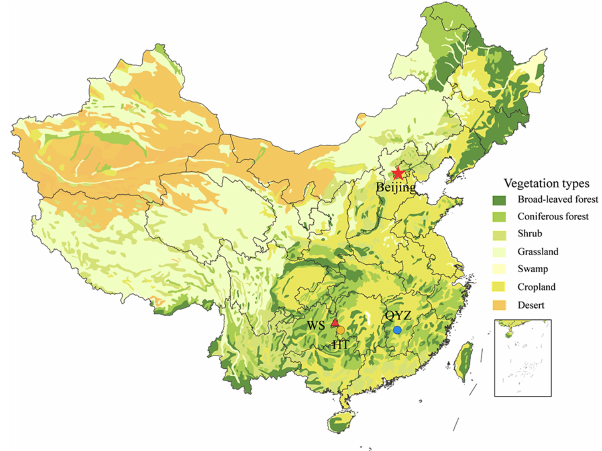
Figure 1. Locations of the QYZ station, HT station and WS Mer- cury Mine. Vegetation map of China (CAS., 2007) as